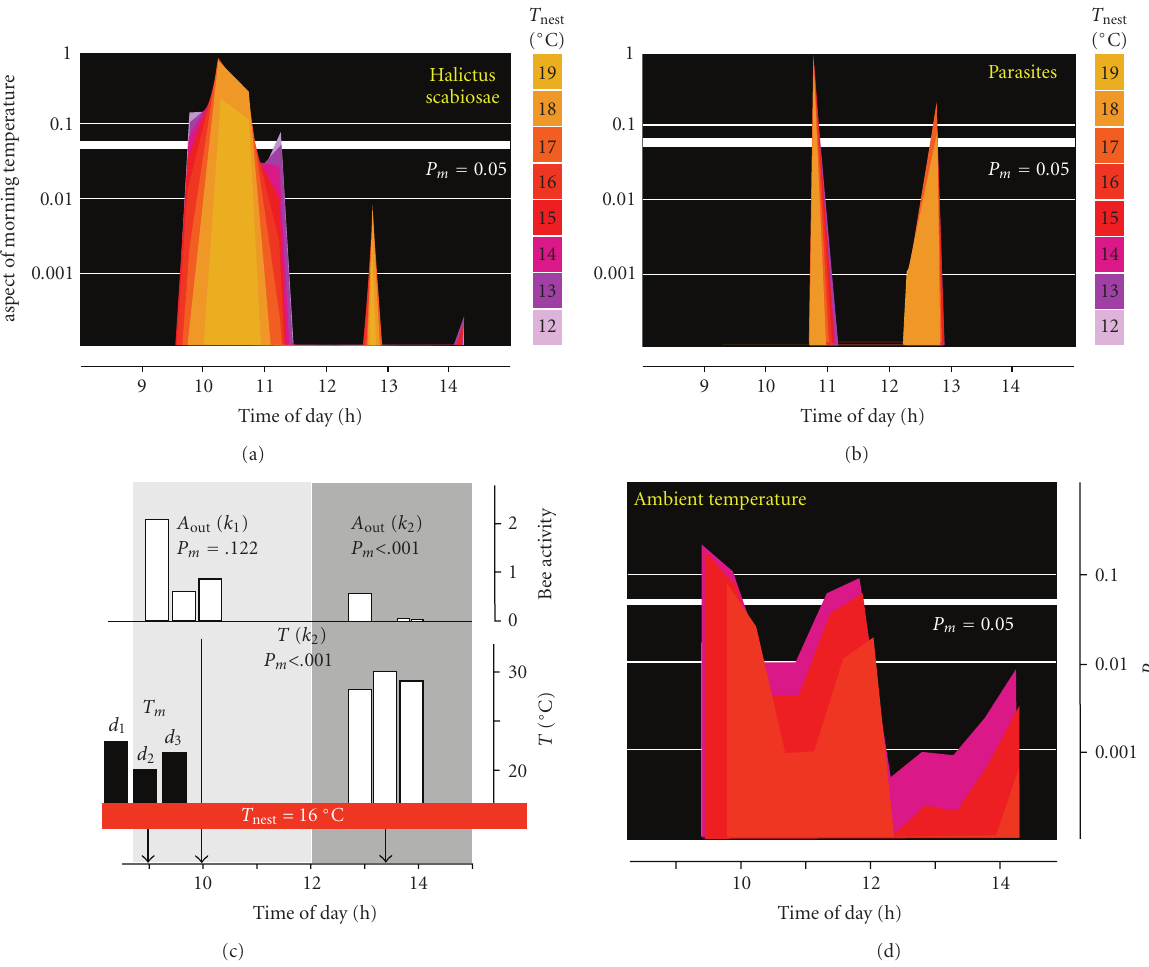
Figure 6: Support for the hypothesis that the aspect of morning temperature (for definition see Methods) determines the foraging activity of Halictus scabiosae and partially also the impact of nest parasites at the H . scabiosae nest over daytime. The abscissa gives the time of the day in hours and the ordinates show the probability of the match ( P m ) with which the morning temperature conditions a ff ect (a) the foraging activity rate in Halictus scabiosae , and (b) the ratio of the impact rates of parasites at Halictus scabiosae nests. The temperature conditions in the morning for the bees or parasites (for definition, see Methods) refer to the ambient temperature which was measured outside of the nest as well as to the temperature inside of the nest, which has been introduced into the model as a virtual parameter in the range from 12 ◦ C (blue violet) to 19 ◦ C (bright orange). The probability P m was calculated by chi-square tests for each time step of 30 minutes of the entire observation time. (c) explains the assessment of the probability P m ; P m > . 05 (chi-square test) signifies similarity, and P m > . 05 signifies contrast. T m : morning aspect of temperature on the three successive experimental days (d 1 ,d 2 ,d 3 ) defined for the initial hour of experiments; A out ( k 1 ) and A out ( k 2 ): the relations of outflyer activities in the observation intervals k 1 (9:30–10:00 h) and k 2 (13:30–14:00 h) on the three successive experimental days (d 1 ,d 2 ,d 3 ) with the P m ( k 1 )-values 0.122 and P m ( k 2 ) < . 001. T ( k 2 ): the temperature relations in the early afternoon in the observation interval k 2 with P m < . 001; the examples refer to a virtual nest temperature of T nest = 16 ◦ C (d) gives the probability P m by comparing the morning aspect of temperature on the days d 1 –d 3 with the ambient temperature later in the day. The graph shows that the match is decreasing over the day with P m < . 05 for nest temperatures greater than 15 ◦